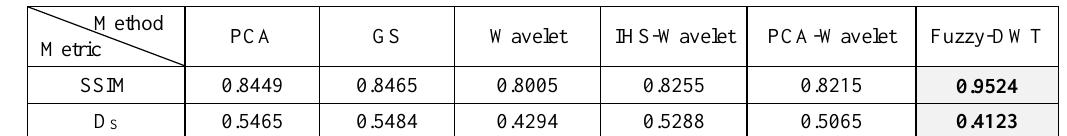
Table 3: Results of the spatial quality assessment of six pan-sharpening outputs